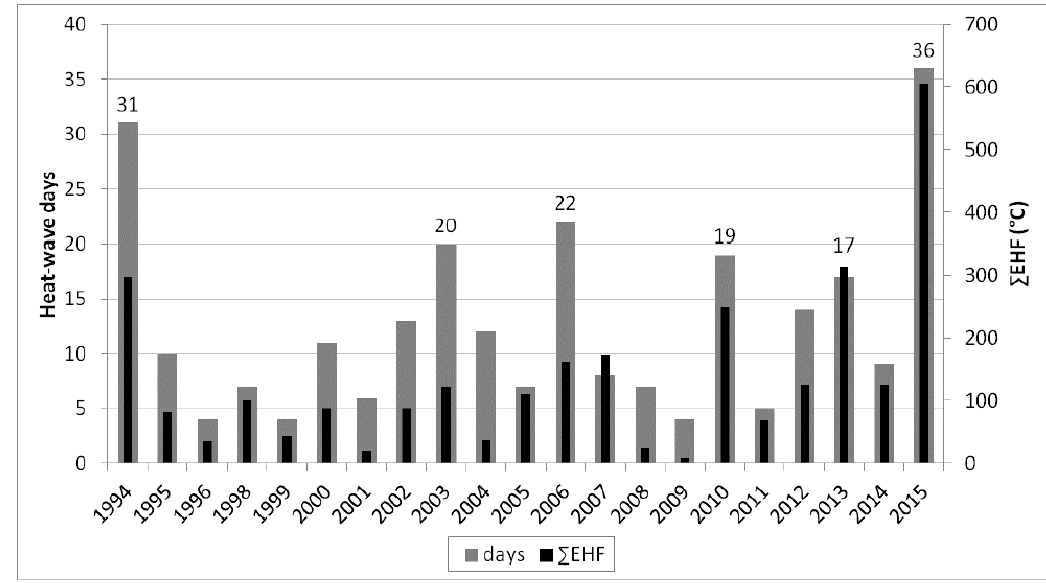
Figure 2. Total duration of heat waves in each year during 1994–2015 in the Czech Republic, and their total heat load according to the cumulative excess heat factor ( ∑ EHF).